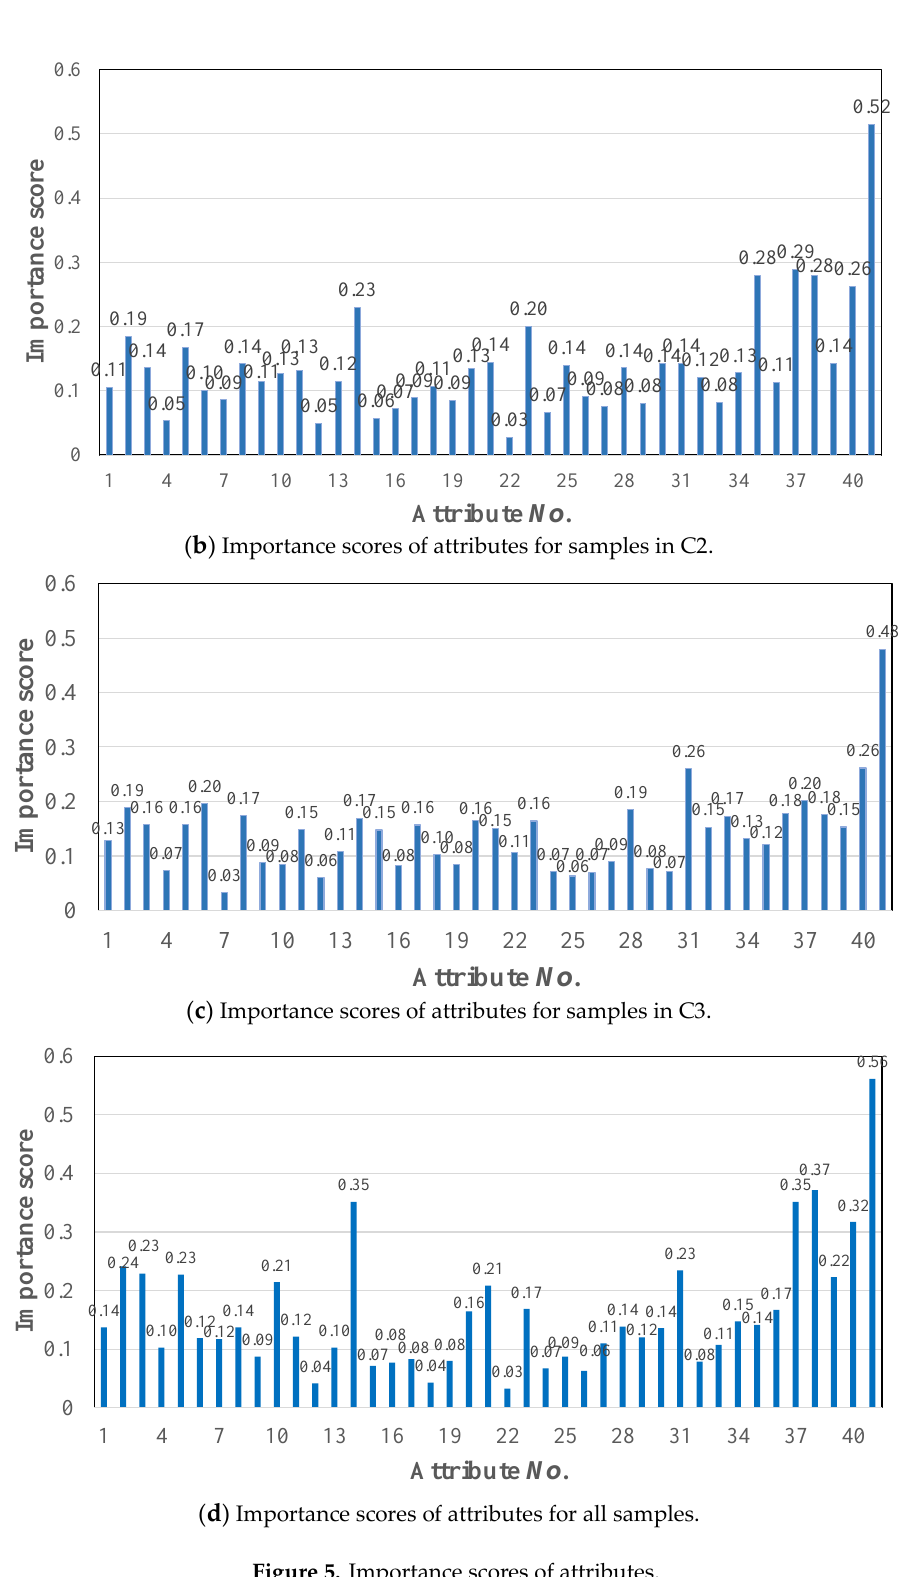
Figure 5. Importance scores of attributes. Table 4. Selected attributes for each category/all samples.